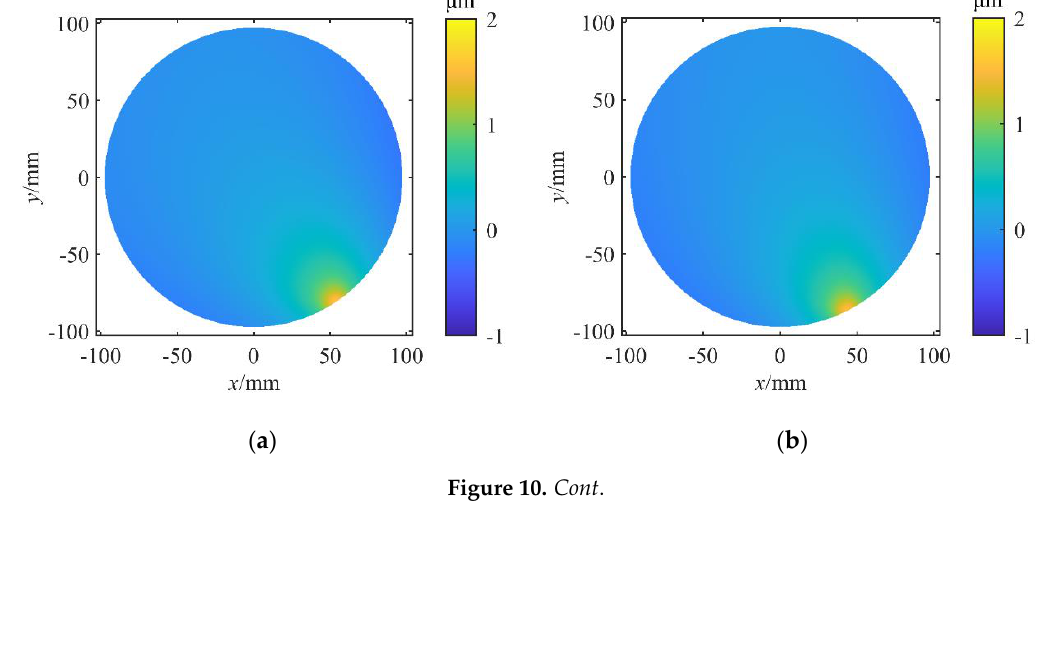
Figure 9. Wafer deformations under unit stress load on one subarea ( a ), its adjacent subarea ( b ), and their difference ( c ) when the number of subareas was 336.